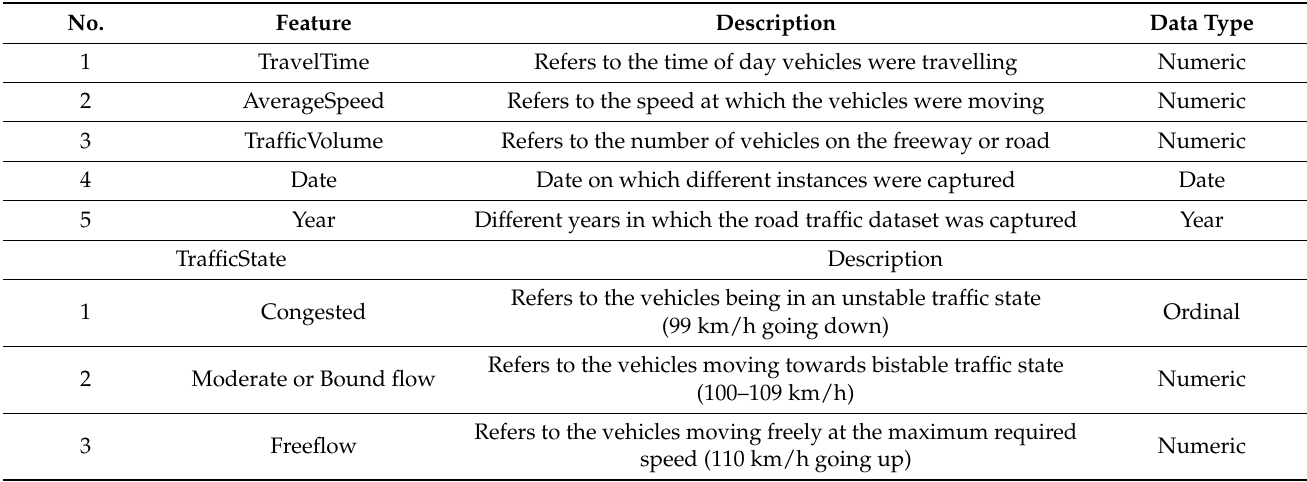
Table 4. RTC features and classes